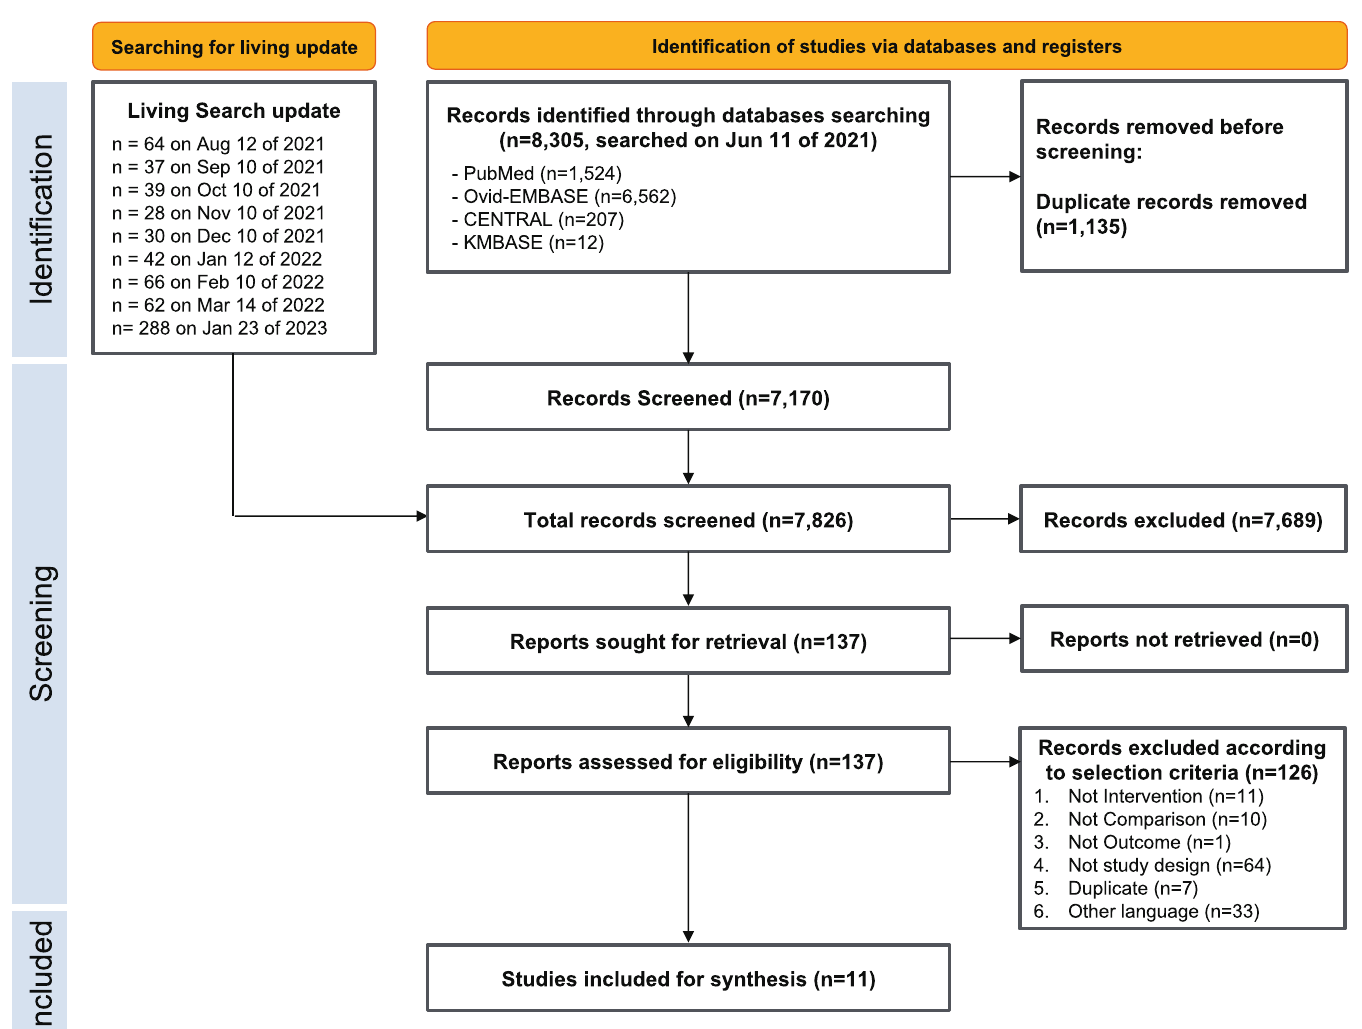
Fig 1. Preferred reporting items for systematic reviews and meta-analyses (PRISMA) study